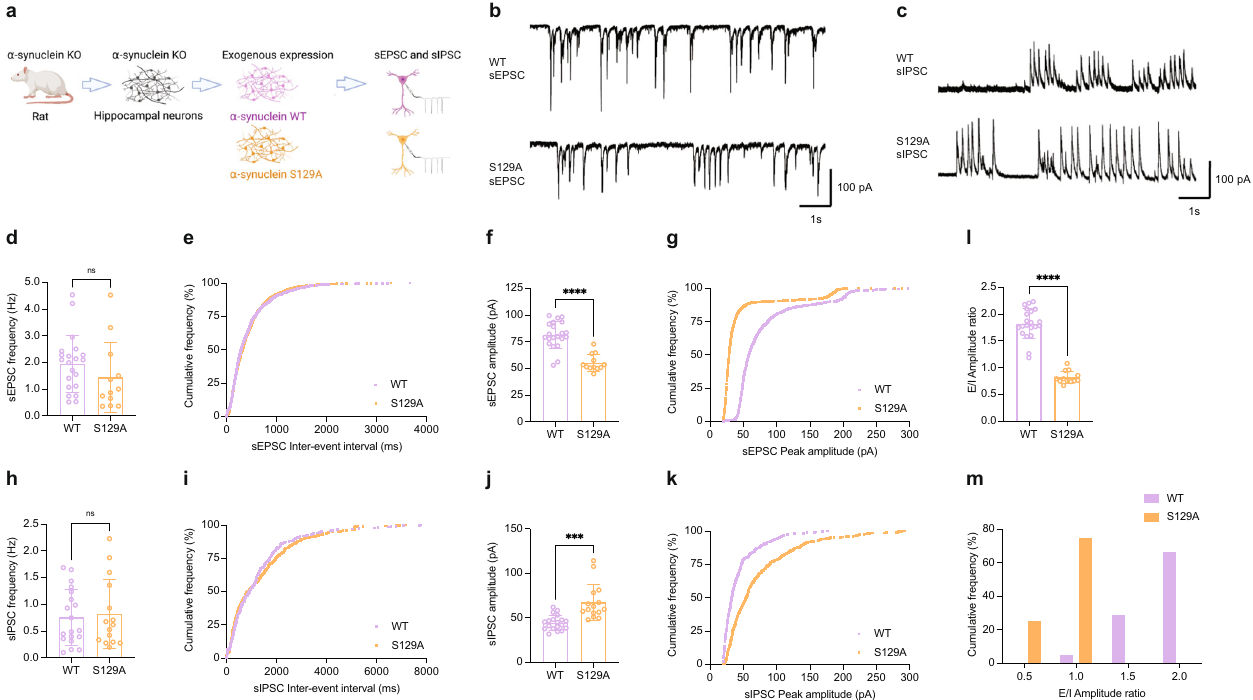
Fig. 6 Phospho-de fi cient S129A α S reduces the excitatory/inhibitory balance in rat SNCA − / − hippocampal neurons. a Spontaneous excitatory (sEPSC) and inhibitory postsynaptic currents (sIPSC) measured in DIV14-18 hippocampal neurons from SNCA − / − rats transduced with α S WT or α S S129A (schematics created with BioRender.com). b Representative sEPSC traces. c Representative sIPSC traces. Scale bars, X - axis = 1 s and Y -axis = 100 pA. d sEPSC frequency in SNCA − / − neurons expressing WT α S or α S S129A. e Cumulative frequency distribution of data shown in d , expressed as percentage. f sEPSC amplitude in SNCA − / − neurons expressing α S WT or α S S129A. g Cumulative frequency distribution plot of data shown in f , expressed as percentage. Total number of individual events analyzed in panels e and g : α S WT = 1228; α S S129A = 1701. Total number of individual cells across two independent neuronal cultures ( N = 2 ) recorded in sEPSC experiments: WT α S = 21 and α S S129A n = 12. h , i sIPSC frequency between conditions as bar charts and cumulative distribution, respectively. j sIPSC amplitude in SNCA − / − neurons expressing WT or S129A α S. k Cumulative frequency distribution of data shown in j . Total number of individual events analyzed in panels i and k : α S WT = 302; α S S129A = 585. Total number of individual cells across two independent neuronal cultures recorded in sIPSC experiments: α S WT = 19 and α S S129A = 15. l , m The excitatory/inhibitory ratio of the amplitude as a bar chart and cumulative frequency distribution, respectively. E/I amplitude ratios were derived from f and j . Respective averages in f ( α S WT or α S S129A) were divided by respective individual values ( α S WT or α S S129A) in j to obtain E/I amplitude ratios. Each circle represents an individual cell. Recordings performed on at least three different days. Unpaired t -tests with Welch ’ s correction; two-tailed; mean ± SD; ns not signi fi cant; *** p < 0.001; **** p <